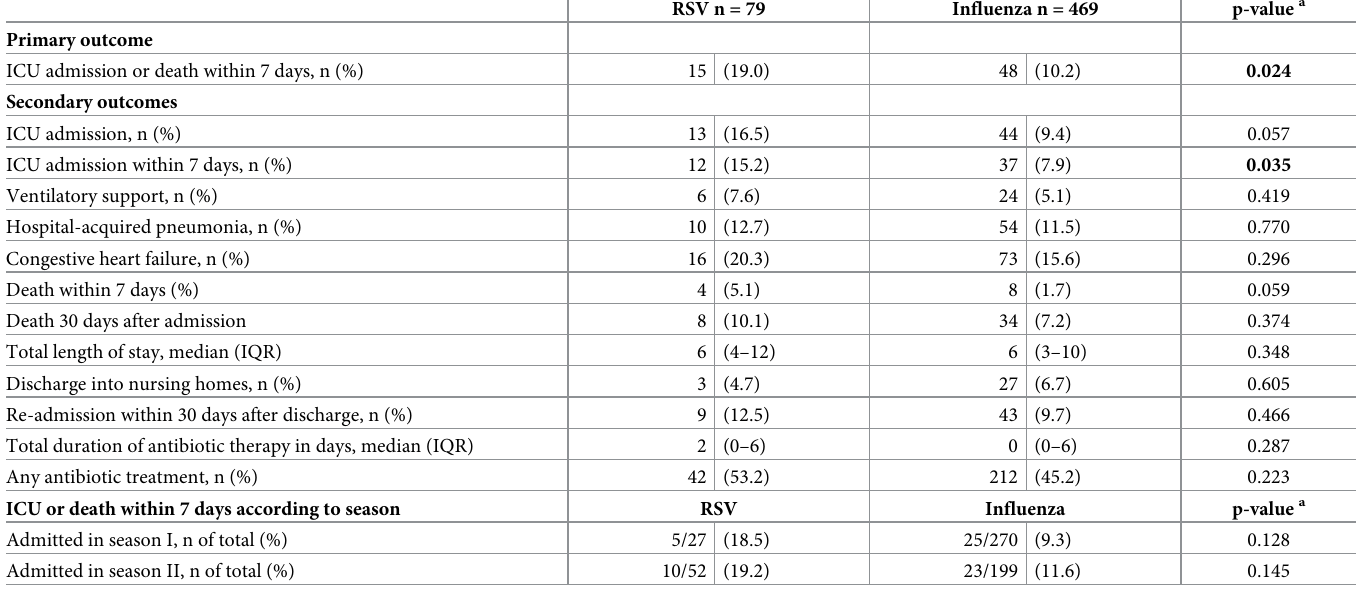
Table 2. Outcomes of patients with laboratory confirmed RSV and influenza virus